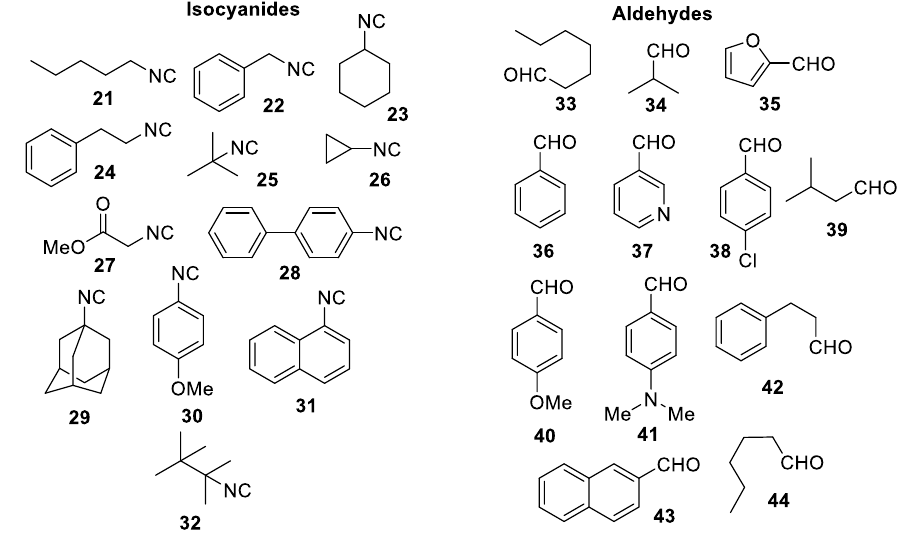
Figure 3. Isocyanides and aldehydes used.